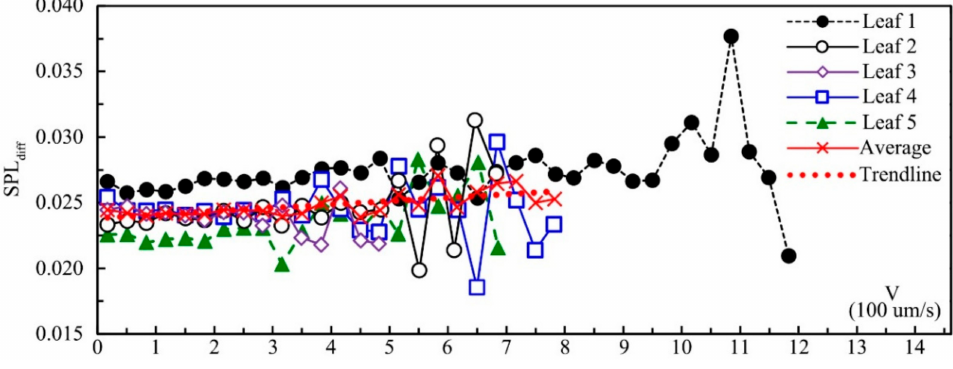
Figure 10. The influence of leaf velocity on sound pressure